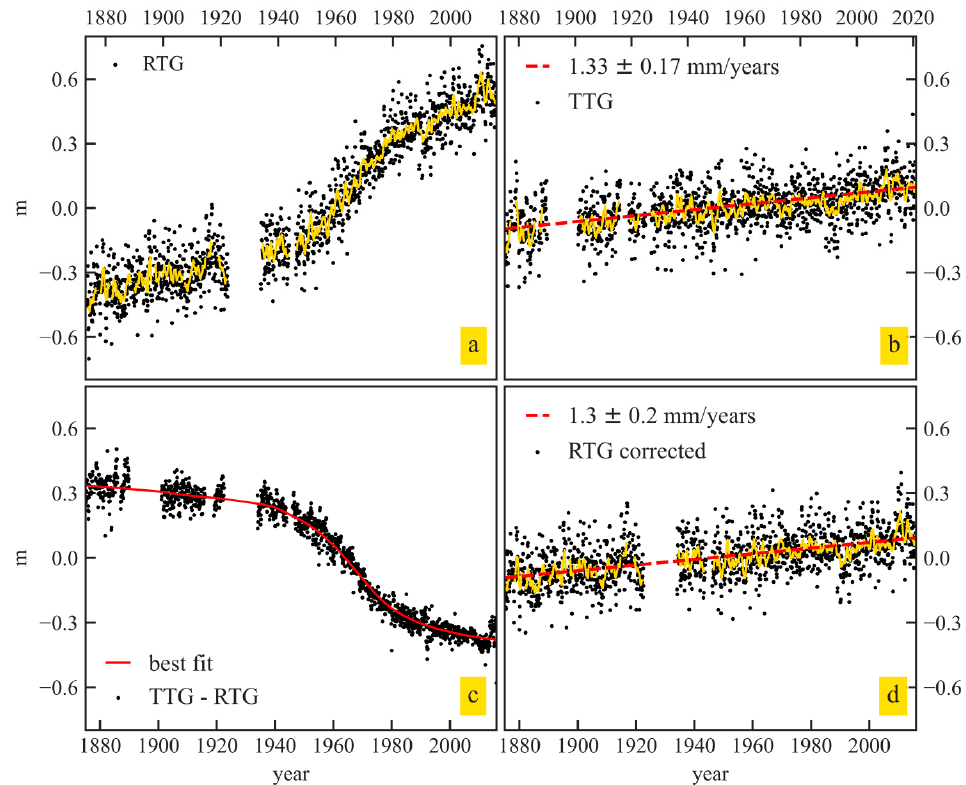
Figure 4. ( a ) RSL recorded at the Marina di Ravenna tide gauge (RTG, 1873–2016) and related 1-year moving window time series (yellow line); ( b ) the TTG, 1875–2021), related trend estimate (dashed red line), and 1-year moving average time series (yellow line); ( c ) the difference between the TTG and RTG time series with the best fit (solid red) line; ( d ) the RTG time series corrected for vertical land movements, long-term trend estimate (red dashed line), and 1-year moving average curve (yellow line).